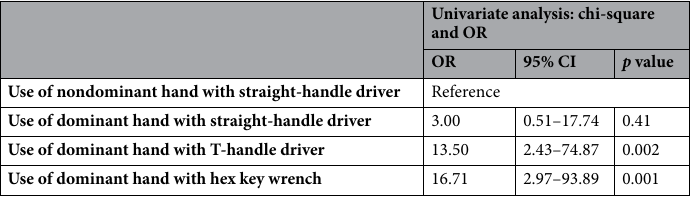
Univariate analysis: chi-square and OR OR 95% CI p value